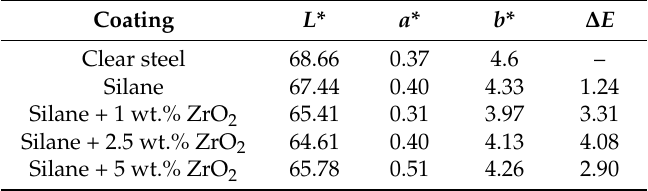
Table 3. Colorimetric parameter ( L *, a *, b *, and ∆ E ) as function of ZrO 2 percentage.